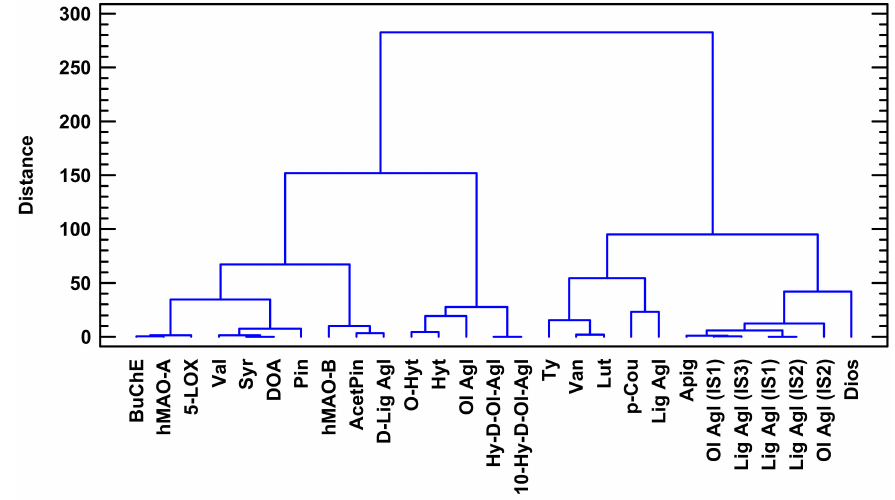
Figure 3. Dendrogram grouping variables according to the squared Euclidean similitude distance by Ward (cid:48) s method. Enzymatic variables of BuChE, h MAO-A and 5-LOX were highly correlated with phenolic variables of Val, Syr, DOA and Pin. All of them were closely connected to h MAO-B, which was highly correlated with AcetPin and D -Lig Agl. The rest of phenolic compounds were separated at linkage distances higher than 150. Variables abbreviations are described in Figure